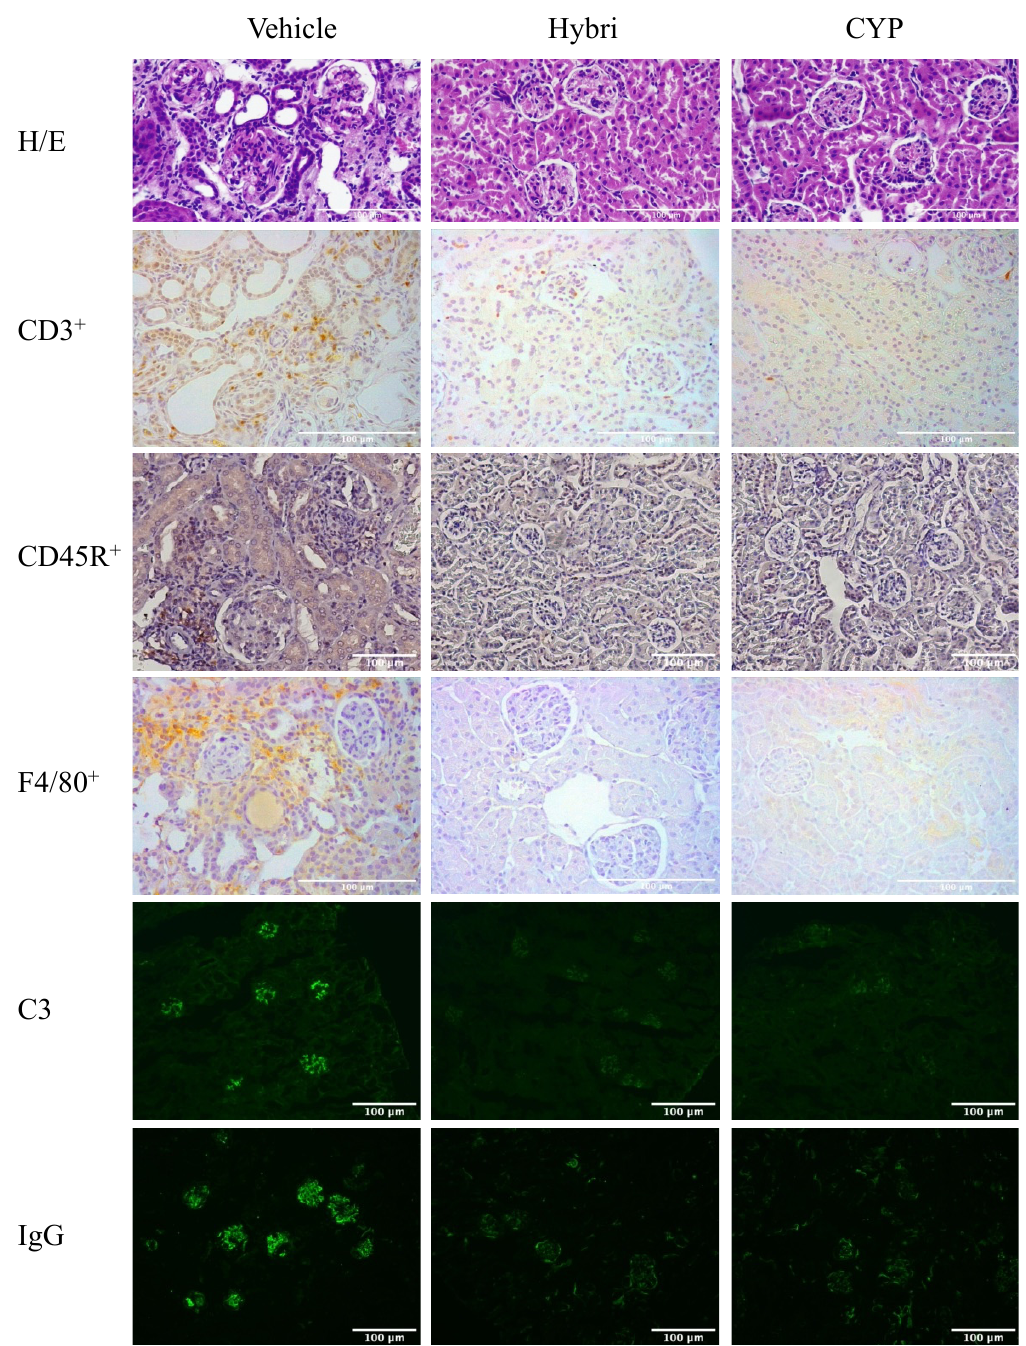
Figure 3. Effect of different treatments on the kidneys in the NZBWF1 study. Representative histological images of hematoxylin and eosin staining and CD3 + , CD45R + , and F4/80 + infiltrate using immunohistochemistry. Immunofluorescence images of C3 and IgG deposition.